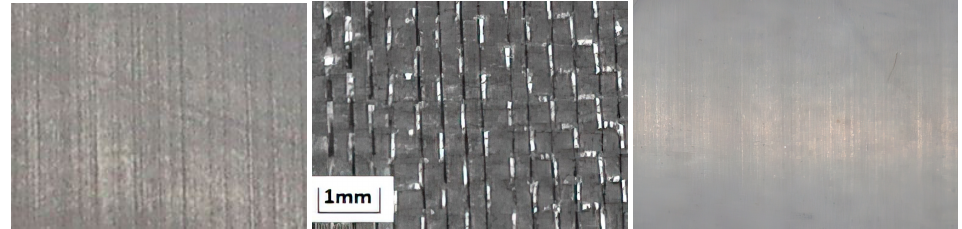
Figure 1. Surface structure of Teflon ( left ), Nylon mesh ( middle ), and Silicone ( right